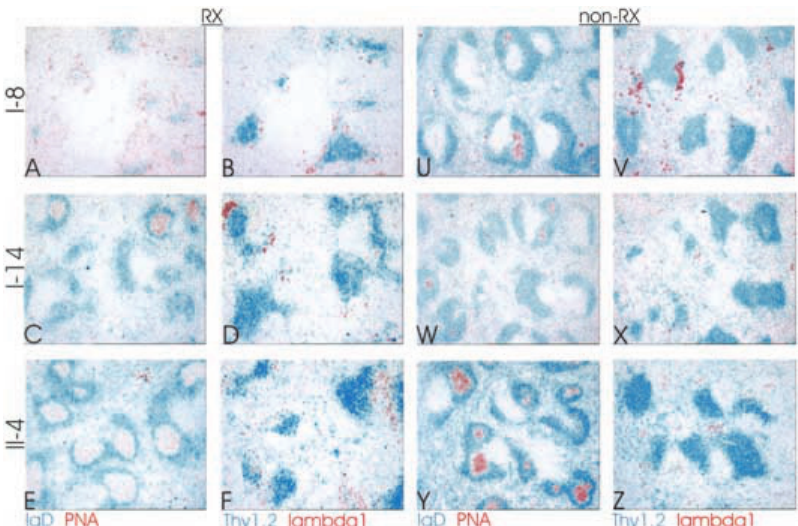
FIGURE 3 Effect of irradiation on splenic architecture and NP-specific structure development. Spleens from A–D, RX-P.S. and U–X, non-RX mice were collected 8 days (A, B, U and V) and 14 days (C, D, Wand X) after primary immunization with NP-KLH precipitated in Alum. Spleens from E, F, RX-P.S. and Y, Z, non-RX mice were collected 4 days after the second stimulation with NP-KLH in PBS. GC and B cell follicles were visualized with PNA (red) and anti-IgD (blue) Ab, respectively (A, C, E, U, W and Y). In serial cryosections NP-specific structures and T cell zones (PALS) were visualized with anti- l 1 and anti-CD90.2 Abs, respectively (B, D, F, V, X and